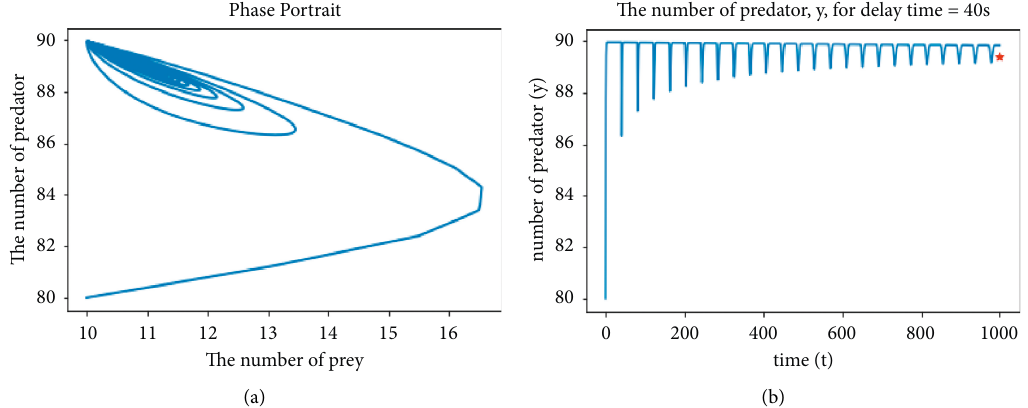
Figure 5: Delay case, τ � 40. (a) The phase portrait; (b) the number of predators with long